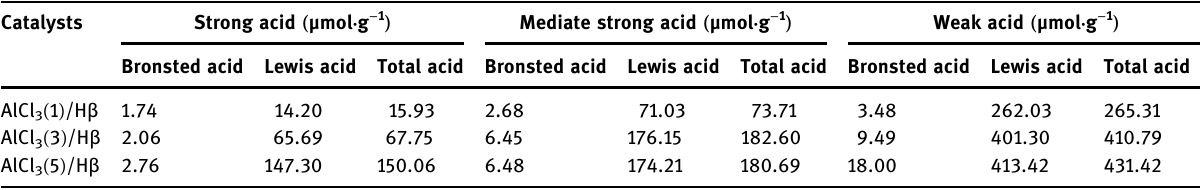
Table 3: Py - IR data of AlCl 3 /H β catalysts prepared with di ff erent concentrations of AlCl 3 Catalysts